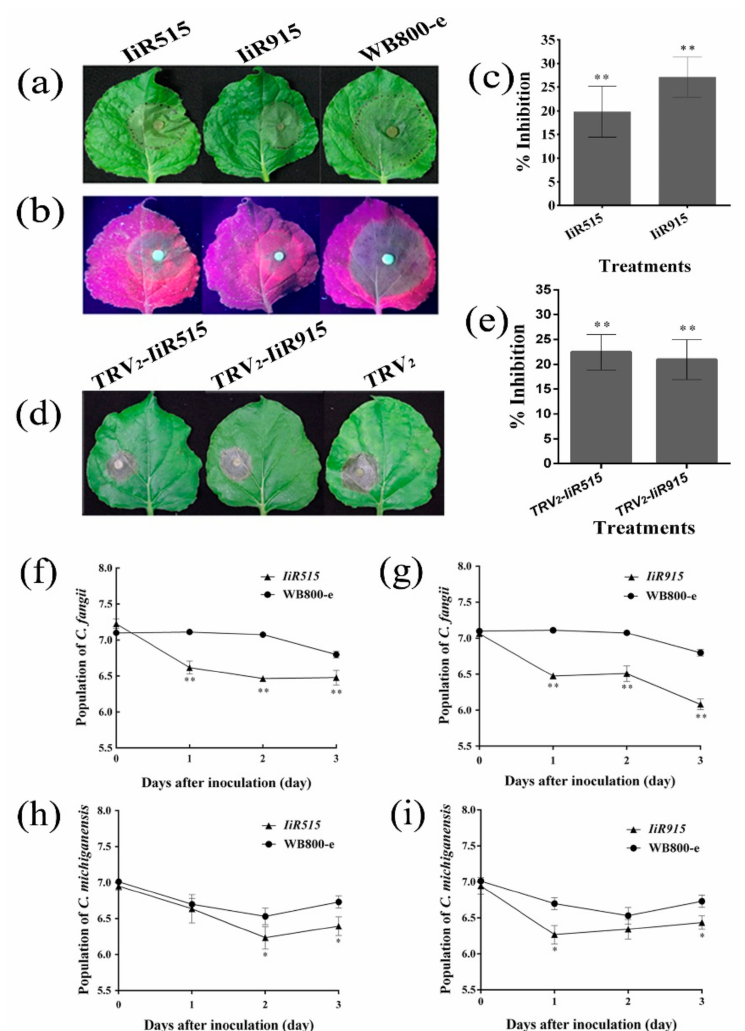
Figure 6. Percent inhibition of Phytophthora capsici and Botrytis cinerea on Nicotiana benthamiana leaves. Images of P. capsici disease inhibition ( a ) under normal light and ( b ) ultraviolet light (365 nm). ( c ) Percent inhibition compared to the control. ( d ) Images of B. cinerea inhibition and ( e ) percent inhibition compared with the control. The y -axis shows the logarithmic values of the bacterial population (log CFU / 10 g of soil). The inhibitory potential of ( f ) the IiR515 strain and ( g ) the IiR915 strain against C. fangii . Inhibitory potential of ( h ) the IiR515 strain and ( i ) the IiR915 strain against C. michiganensis compared to the control WB800-e strain. Data are the mean values from three individual experiments. Vertical bars represent the SD. For significance analysis, t -tests were performed; * p < 0.05, ** p <